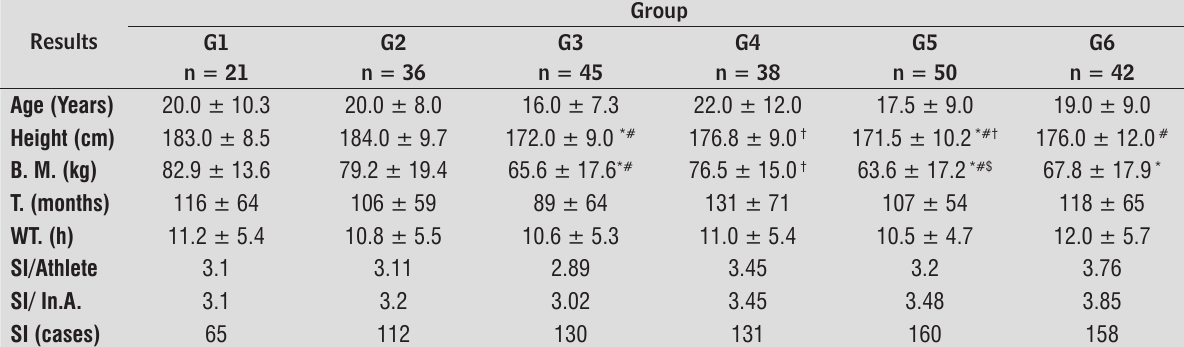
Table 1 - Demographic and anthropometric results, and epidemiology of sports injuries according to soccer player position Results